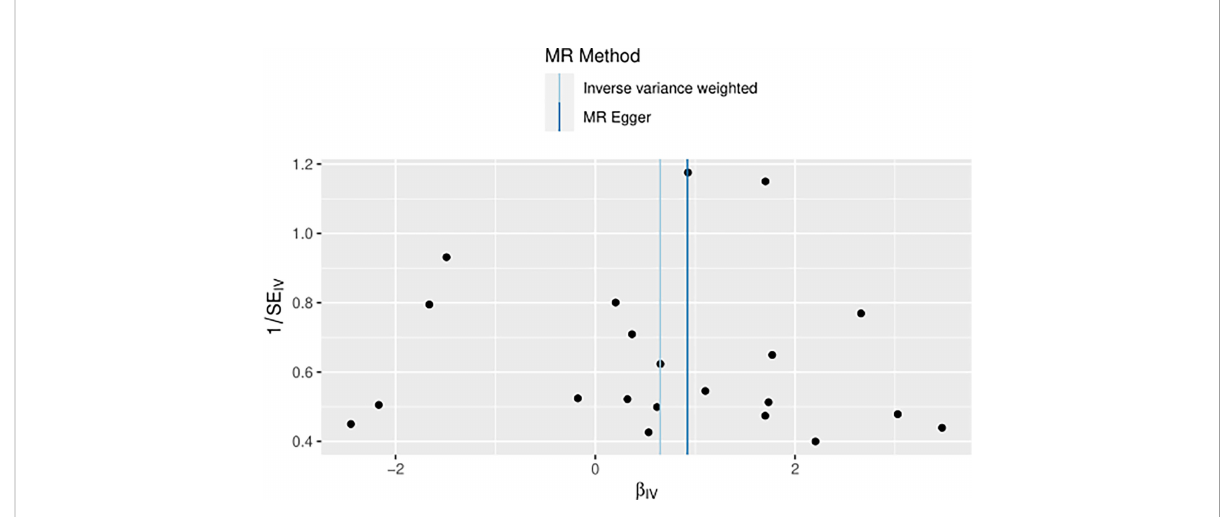
FIGURE 6 Funnel diagram of instrumental variable (BN !